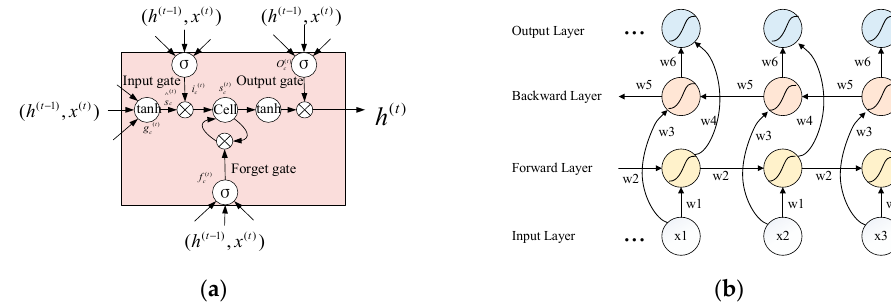
Figure 1. Structure of LSTM and its variants: ( a ) LSTM; ( b ) Bi-LSTM.